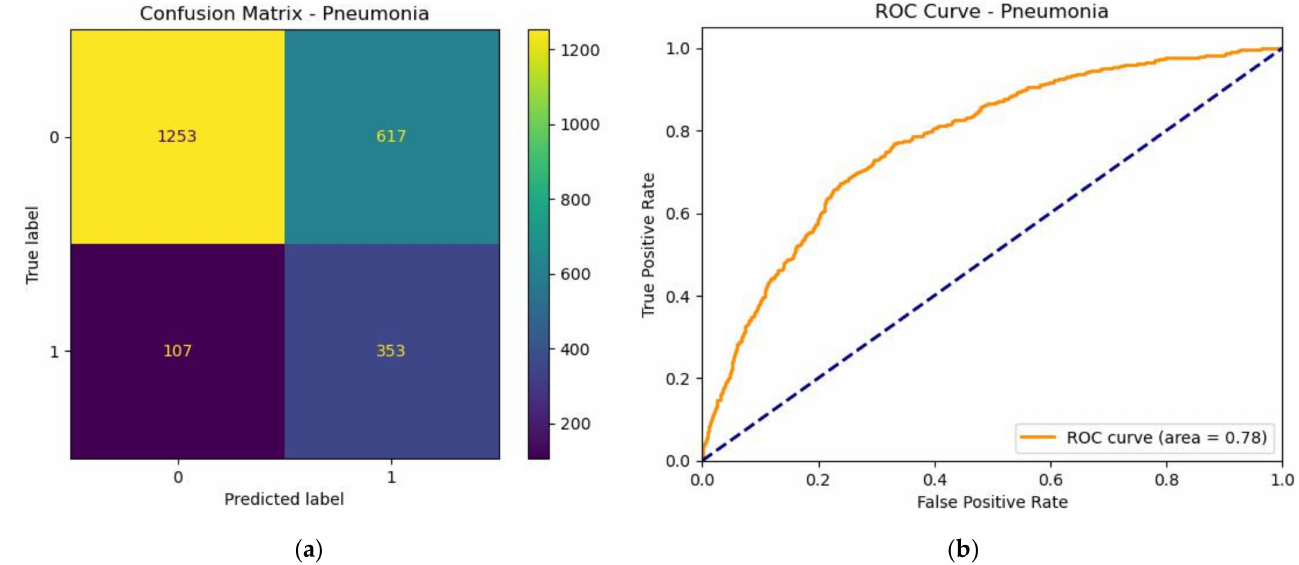
Figure 5. Model quality—Pneumonia. ( a ) Confusion matrix. ( b ) ROC